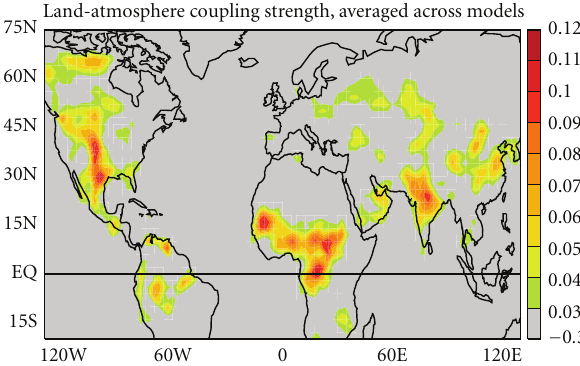
Figure 3: The soil moisture-atmosphere coupling strength diagnos- tic for boreal summer (the di ff erence, dimensionless, describing the impact of soil moisture on precipitation), averaged across the 12 participating models. Courtesy by Dr. Randy Koster of NASA based on Koster et al.